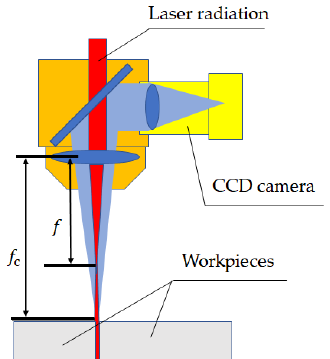
Figure 3. Scheme for determining the focal length of laser radiation and CCD camera.